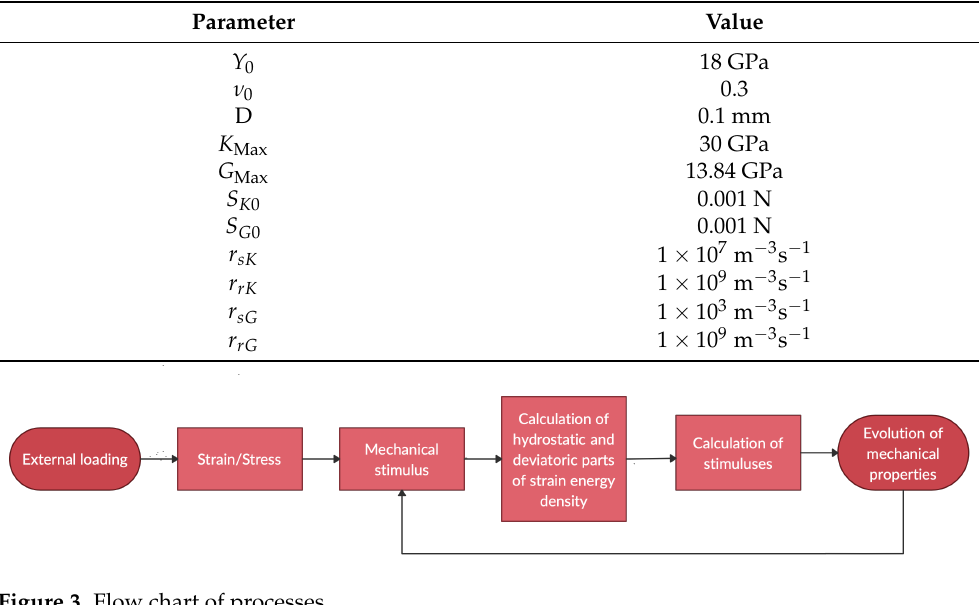
Table 1. Parameters used in the numerical simulations.